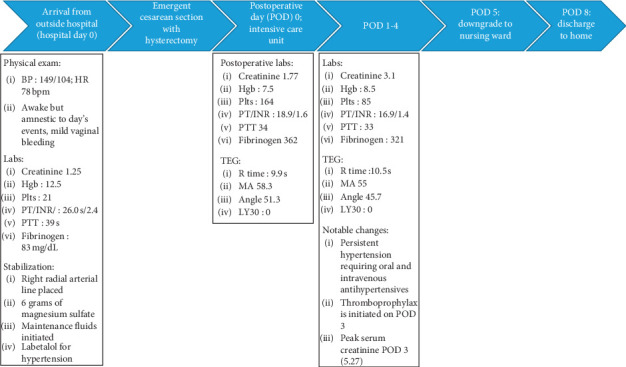
Time course flow-chart of the most significant events.